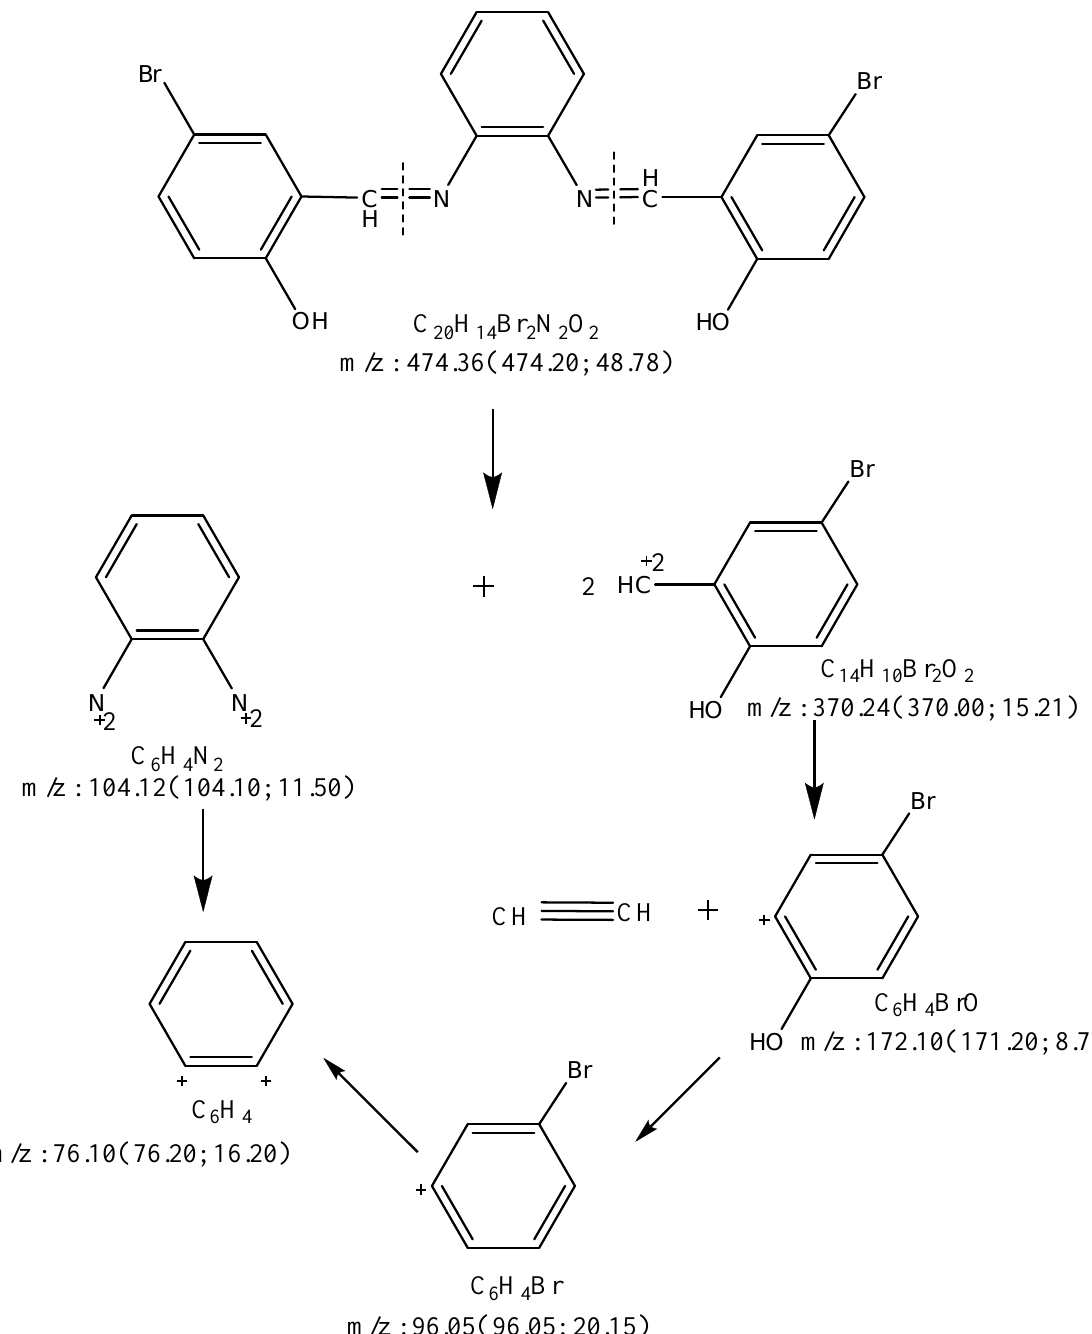
Scheme 1. Mass fragmentation pattern for free ligand. Table 4. Magnetic moment and electronic spectral data of ligand and its Zn-nano complex. Compd.